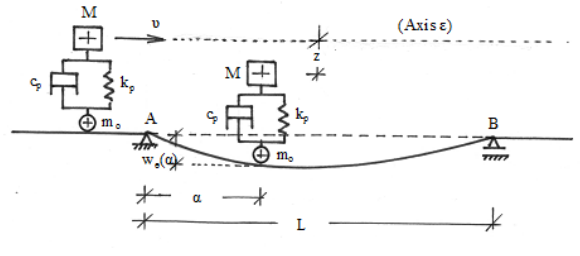
Figure 4: The damped